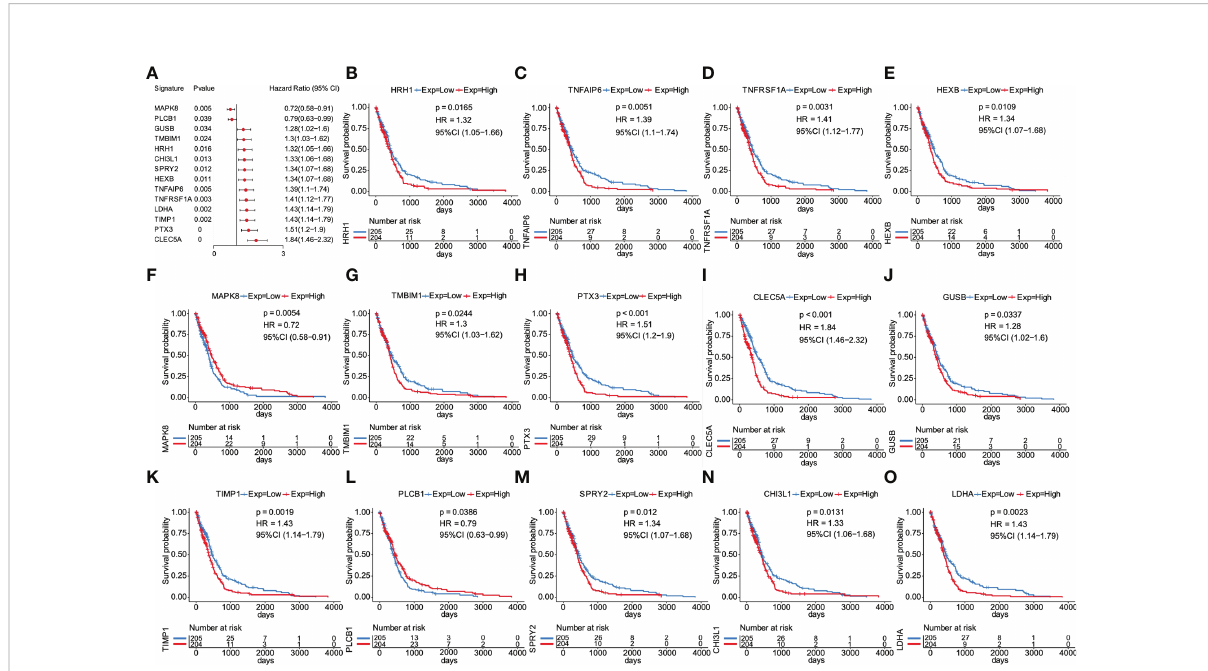
FIGURE 5 Screening of overall survival – associated glycolytic core genes. (A) 14 genes signi fi cantly associated with GBM patients ’ OS among 23 glycolytic core genes. (B) Survival analysis of 14 genes for GBM patients in the TCGA database, including HRH1 (B) , TNFAIP6 (C) , TNFRSF1A (D) , HEXB (E) , MAPK8 (F) , (G) , PTX3 (H) , CLEC5A (I) , GUSB (J) , TIMP1 (K) , PLCB1 (L) , SPRY2 (M) , CHI3L1 (N) , and LDHA (O)